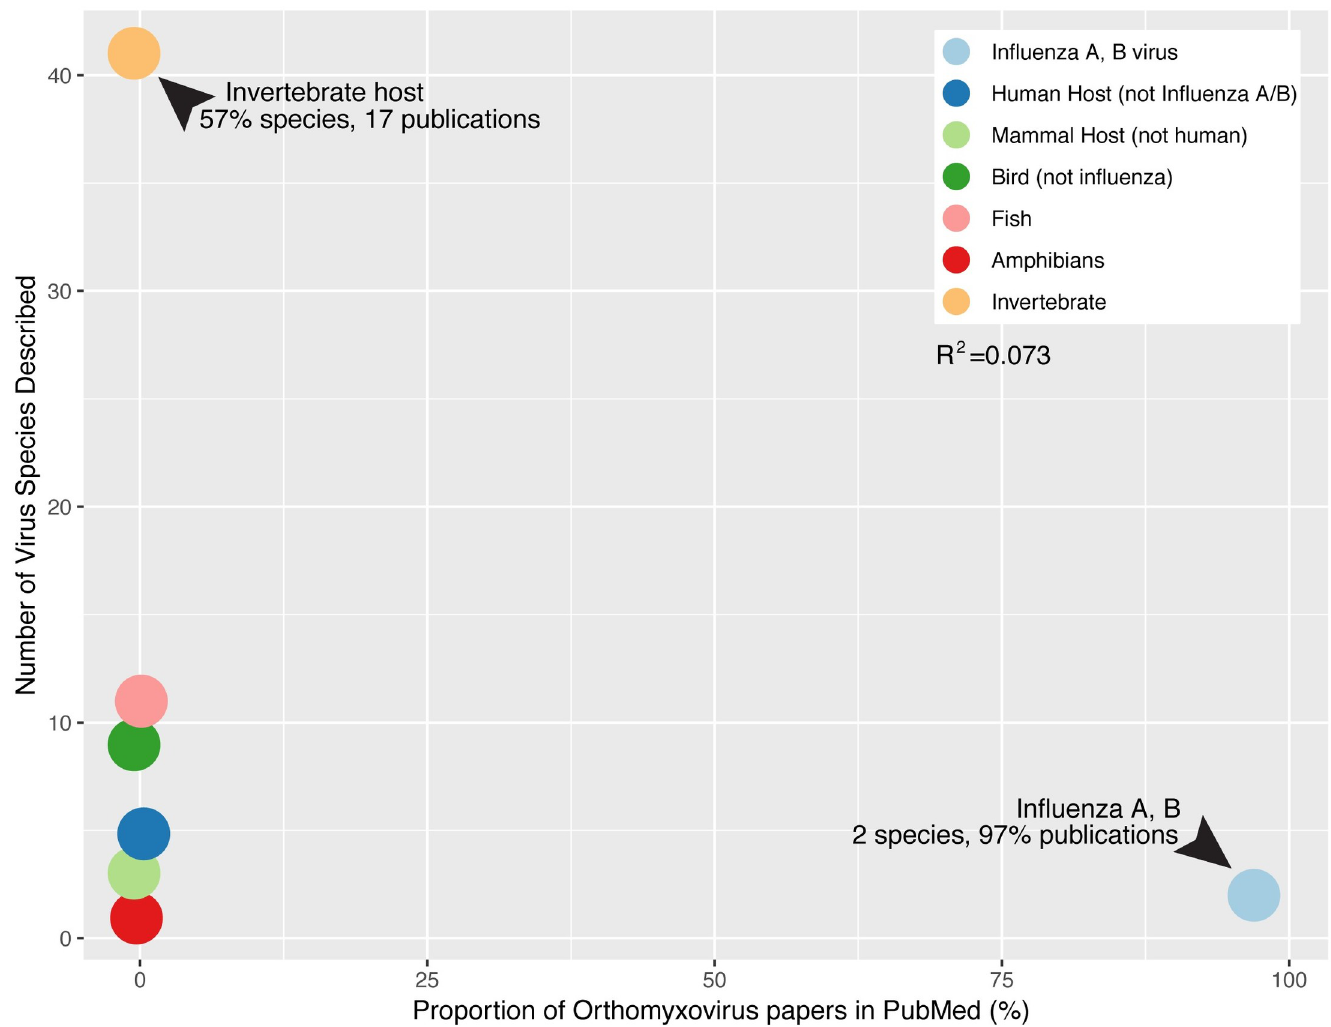
Fig 3. Disparate publication frequency between orthomyxoviruses that cause disease in humans or domestic animals (i.e., influenza A virus and influenza B virus) and those found in underappreciated vertebrate and invertebrate hosts. The source code and underlying data for this figure can be found at https://github.